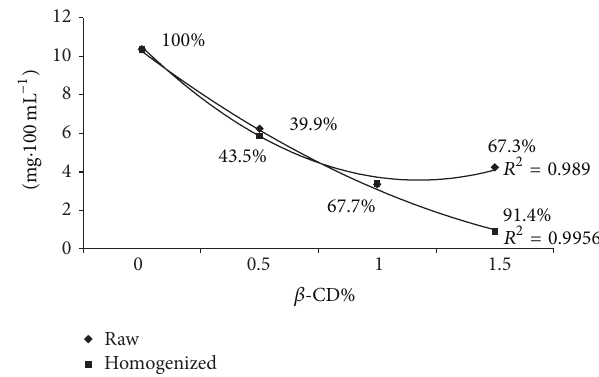
Figure1:Cholesterolreductioninbothrawandhomogenizedmilks by various amount of 𝛽 -CD.